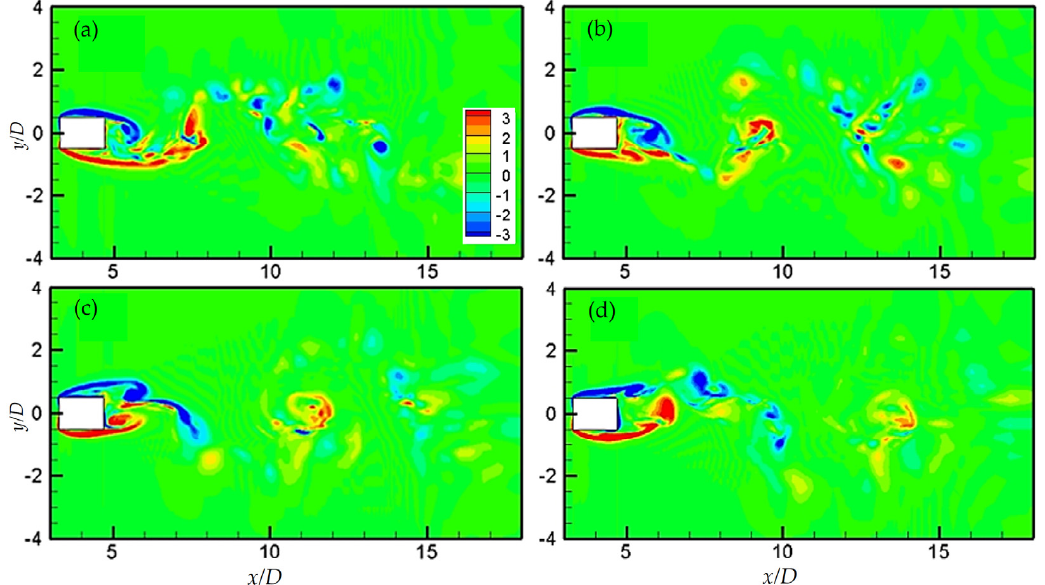
Figure 15. Instantaneous contours of the spanwise vorticity 𝜔 (cid:3053) for α = 45° on the ( x , y ) plane at z = 4 D within one vortex shedding period T. ( a ) t = 0; ( b ) t = T/4; ( c ) t = 2T/4; ( d ) t = 3T/4.